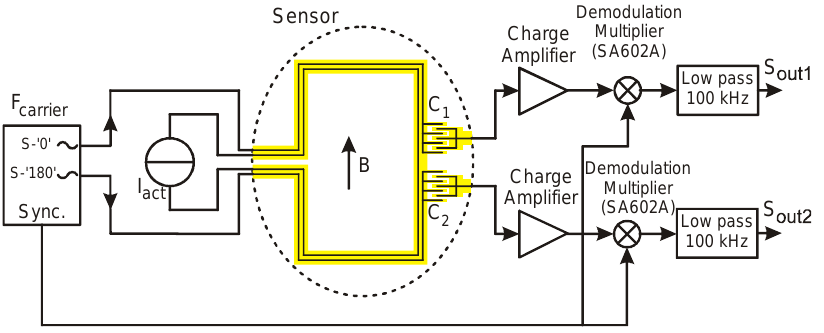
Figure 4. Schematic diagram of the actuation and readout